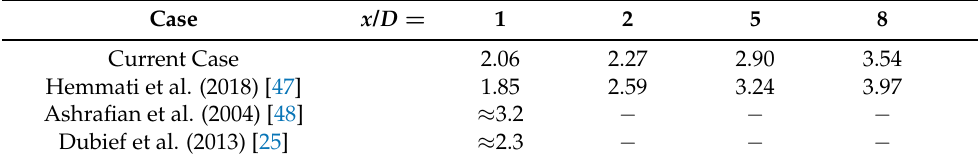
Figure 3. The spatial grid distribution with a magnified box around the bar roughness element. Table 1. Grid resolution, ∆ x / η , for the current DNS